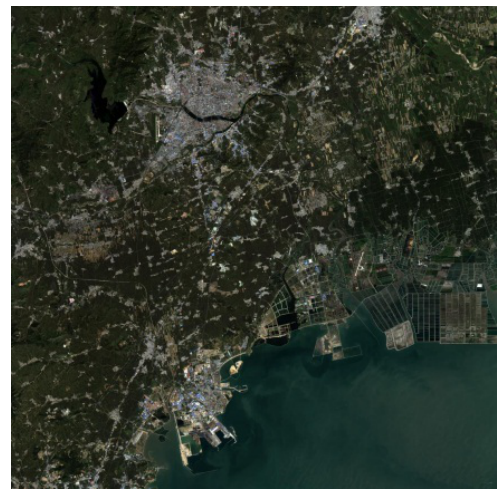
Figure 2. The thumbnail image of the ZY-3 in the